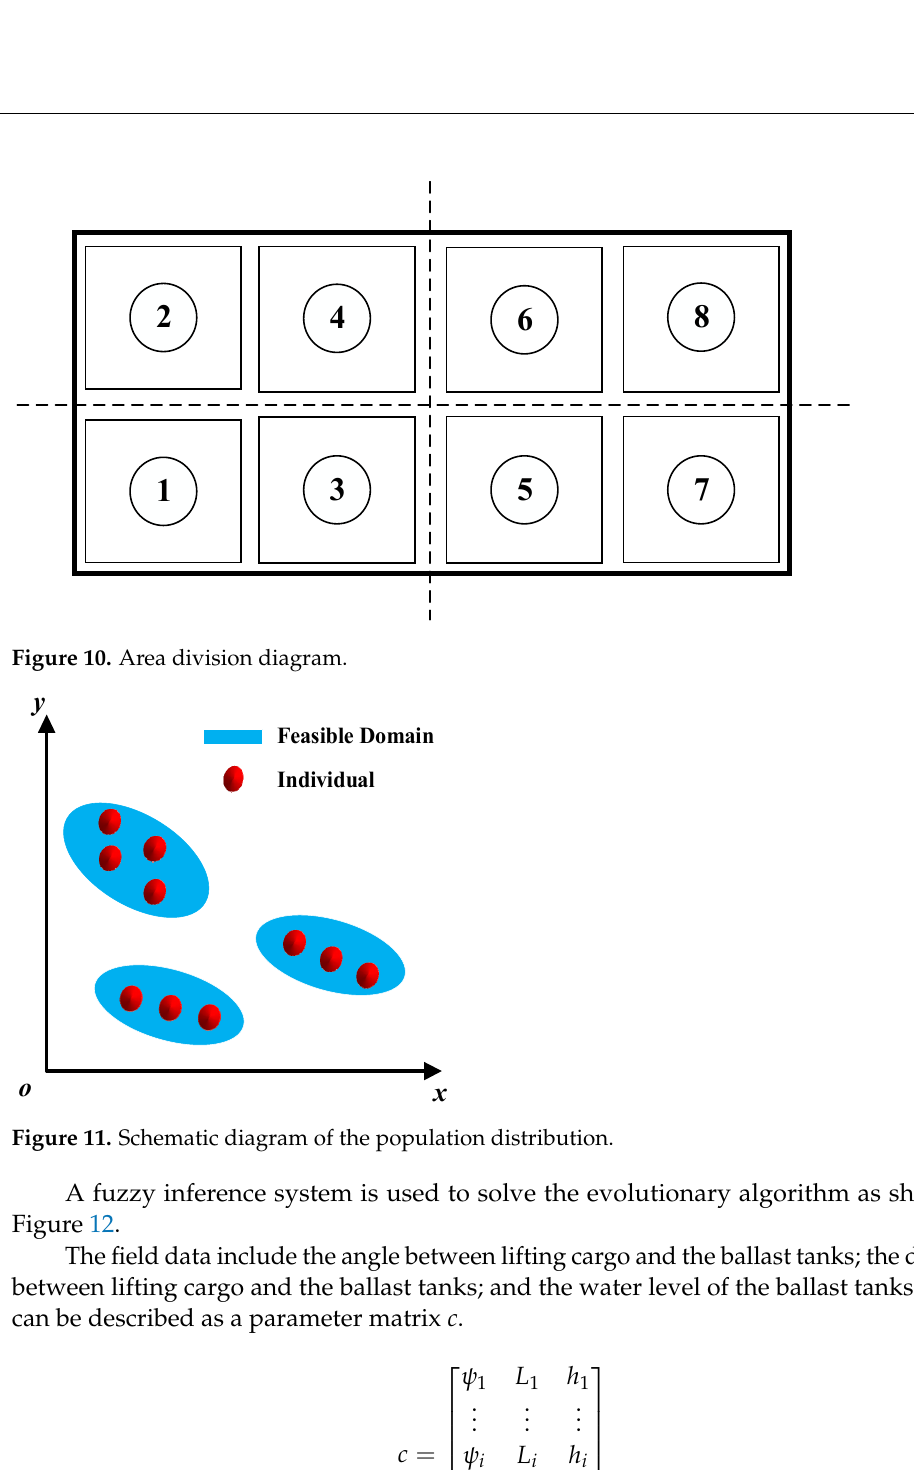
Figure 9. Defuzzification schematic.